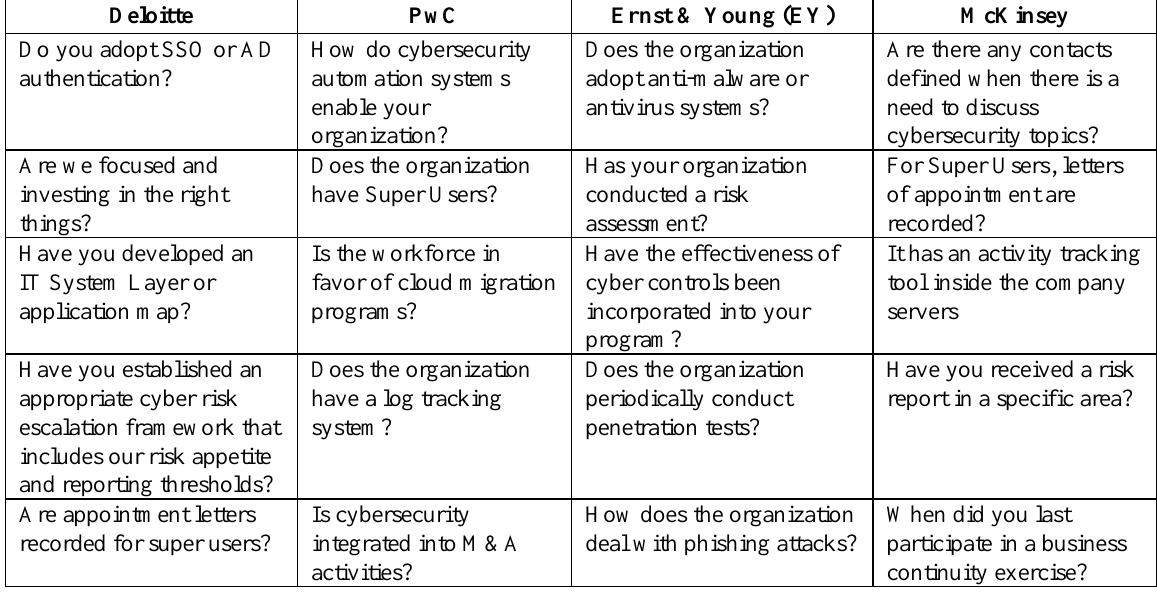
Table 1. Cybersecurity Readiness: Consultancy